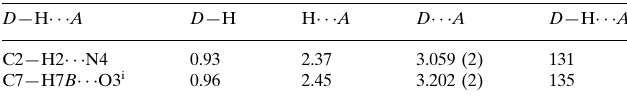
Hydrogen-bond geometry (A˚ , (cid:1)